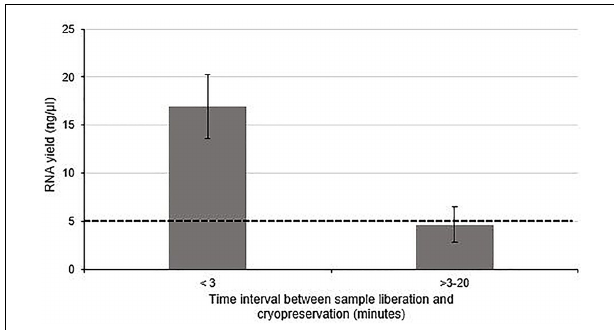
FIGURE 1 | The effect of time between tissue liberation and cryopreservation on RNA yield in human nerve tissue in a surgical environment utilizing standard antiseptic protocols. The duration between nerve tissue removal and freezing was monitored and samples were grouped according to whether the delay was more than ( n = 5) or less than 3 min ( n = 4). There was a statistically significant difference between each group ( p < 0 01 two tailed t -test). The dotted black line represents the minimum concentration of RNA often cited (Bastard et al., 2002; Fleige and Pfaffl, 2006; Wilkes et al., 2010; Fox et al., 2012; França et al., 2012) required for downstream RT-qPCR/RNA seq Data is presented as a mean ± 1 Standard Deviation (SD).